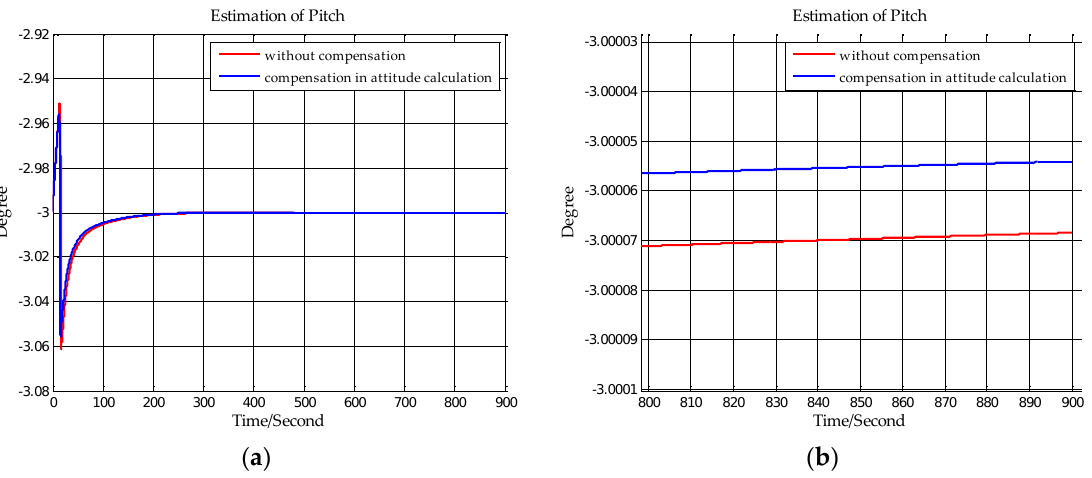
Figure 11. ( a ) is the estimation of pitch with compensation in attitude calculation, and ( b ) is the enlarged view of ( a ) in the last 100 s.